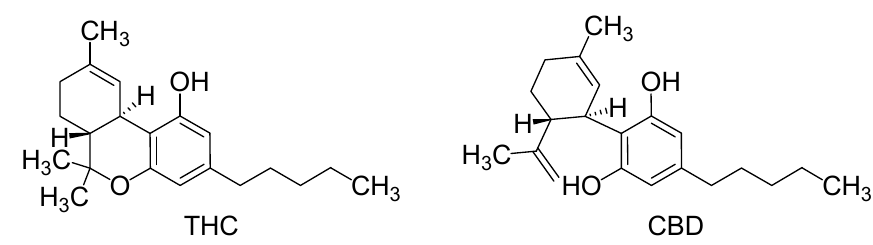
Figure 1. Structures of tetrahydrocannabinol (THC) and cannabidiol